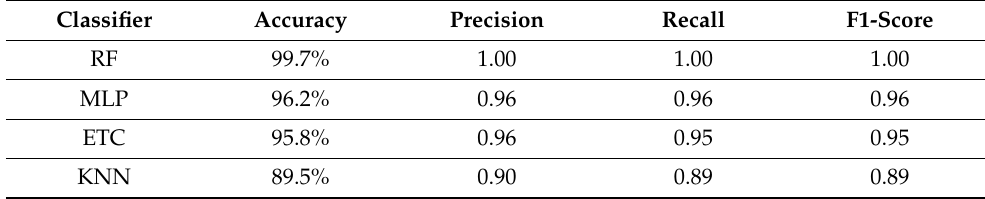
Table 2. Classification results of classifiers with 12 MFCC features.